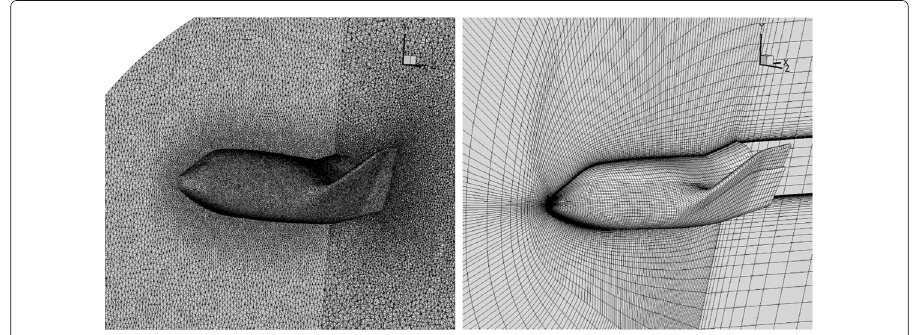
Fig. 2 Computational mesh (left: DSMC, right: